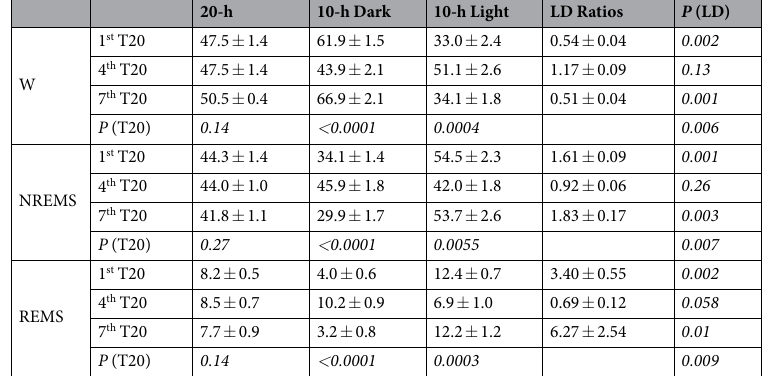
Table 1. Vigilance states under T20 conditions (% [mean ± SEM]). Percentage of wakefulness, non-rapid eye movement sleep (NREMS) and rapid eye movement sleep (REMS) (% of total recording time), and Light/Dark (L/D) ratios (amount of vigilance state spent in the 10-h light phase/10-h dark phase) (B6: n = 5). Statistics are indicated by P values for the ‘T20 cycle effect’ (1-way ANOVA), interaction ‘T20 cycle x Phase’ (2-way ANOVA), and for the Light-Dark difference (paired t- tests).